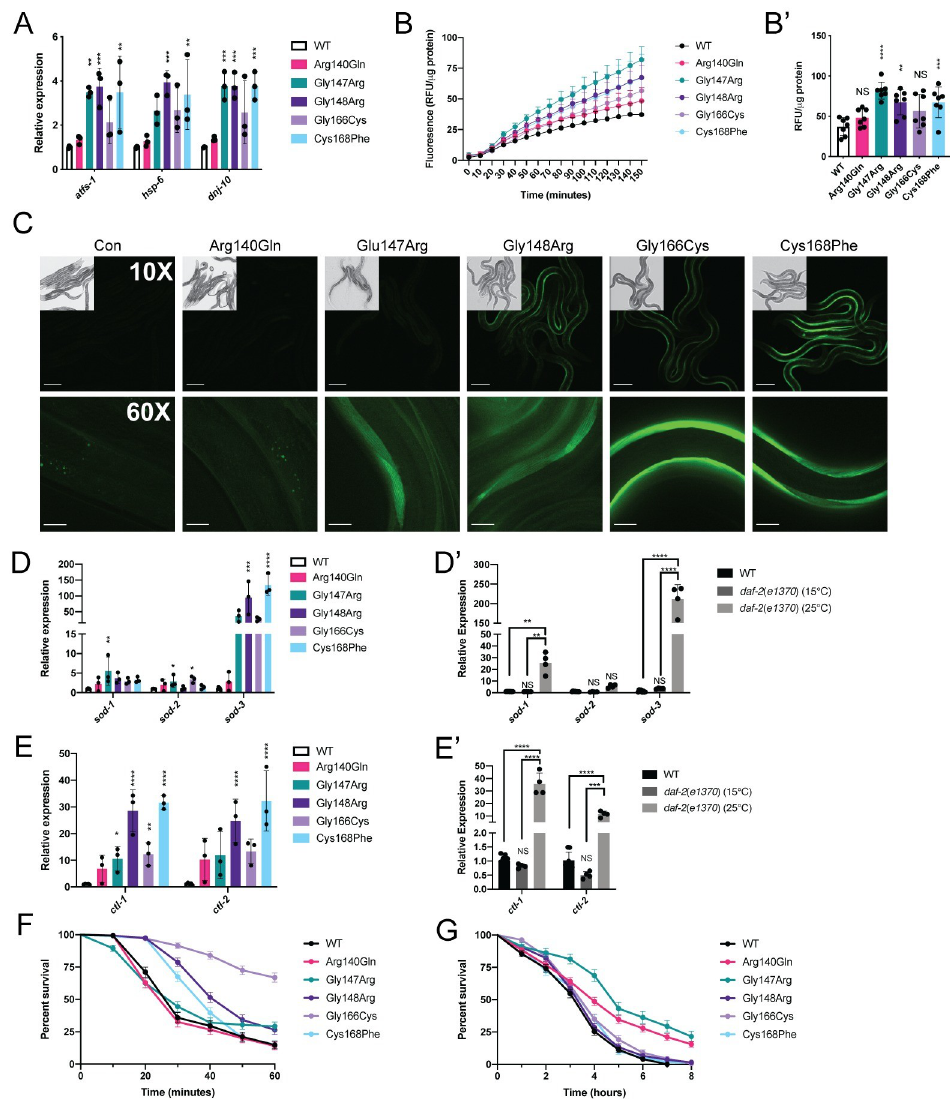
Fig 4. Activation of multiple stress response pathways in nfu-1 mutants. (A) Gene expression of atfs-1 and direct targets in the UPR mt (n = 3). (B-B’) H 2 DCFDA fluorescent signal for ROS (n = 7). (B) Fluorescent signal over time. (B’) End point fluorescent signal. (C) Representative images of the Pgst-4::gst-4::GFP transgene in control (transgene only) and nfu-1 mutants. Scale bar: 100 μ m in 10X; 20 μ m in 60X images. Insets at 10X show DIC image of animals in the field of view. (D-D’) Gene expression of superoxide dismutase genes (n = 3–4). (E-E’) Gene expression of catalase genes (n = 3–4). (F, G) Kaplan-Meier survival curves with exposure to exogenous oxidants. (F) H 2 O 2 exposure (n = 134–175). (G) Paraquat exposure (n = 102–251). Data in (F-G) represented as percentages ± standard error. Statistical analysis in Table 2. � : p � 0.05; �� :p � 0.01; ��� :p � 0.001; ���� :p � 0.0001 difference between (A-B,D,E) WT and nfu-1 mutants by One-way ANOVA with Dunnett correction for multiple comparisons; (D’,E’) all groups by One-way ANOVA with Tukey correction for multiple comparisons. NS: Not significant. RFU: Relative fluorescence units. by the transcription factors SKN-1 and DAF-16, respectively, can both be directly activated by oxidative stress. SKN-1 (orthologue of mammalian NRF2), is tonically expressed but normally proteasomally degraded [53]. When released from its degradation cycle, SKN-1 is transported and metabolic remodeling, especially fatty acid elongation [54–56]. DAF-16 (orthologue of